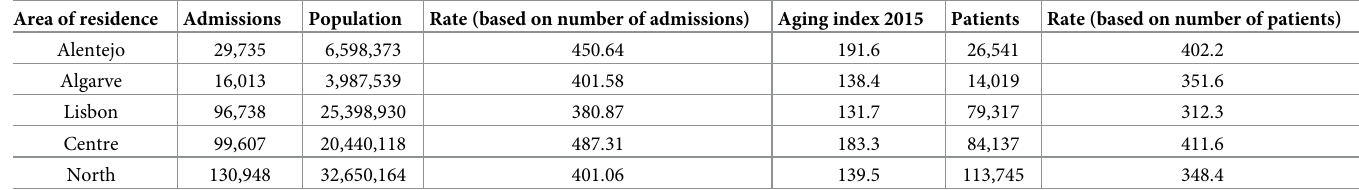
Table 3. Distribution of rates of falls (per 100,000 population at risk) by geographical area of residence, between 2010 and 2018, in the Portuguese